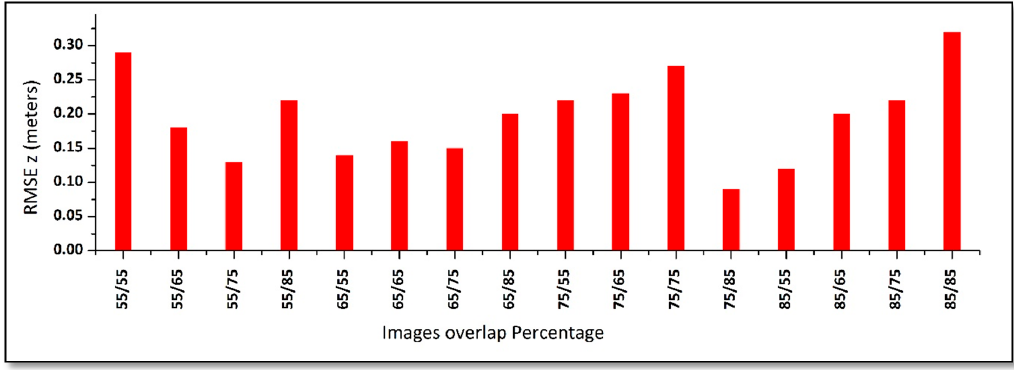
ISPRS Int. J. Geo-Inf. 2020 , 9 , x FOR PEER REVIEW Figure 4. RMSEr for Digital Surface Model (DSM) accuracy assessment. Figure 4. RMSEr for Digital Surface Model (DSM) accuracy assessment.